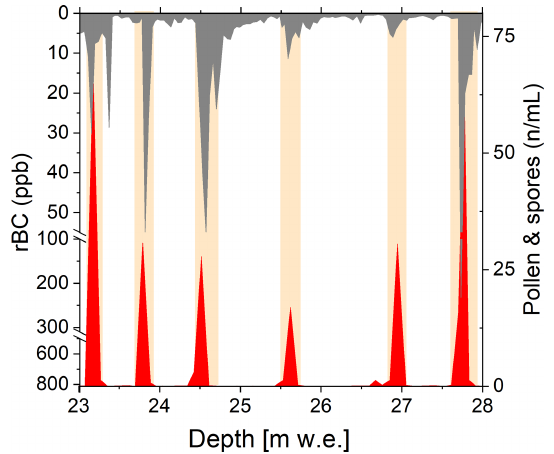
Figure 3. Zoom-in of a 5mw.e. section of the palynomorphs (pollen and spores) and rBC records presented in Fig. 2, highlight- ing the synchronicity of their peak maxima and minima.